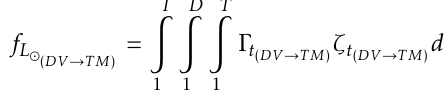
and Γ for I 1 T I 5 T